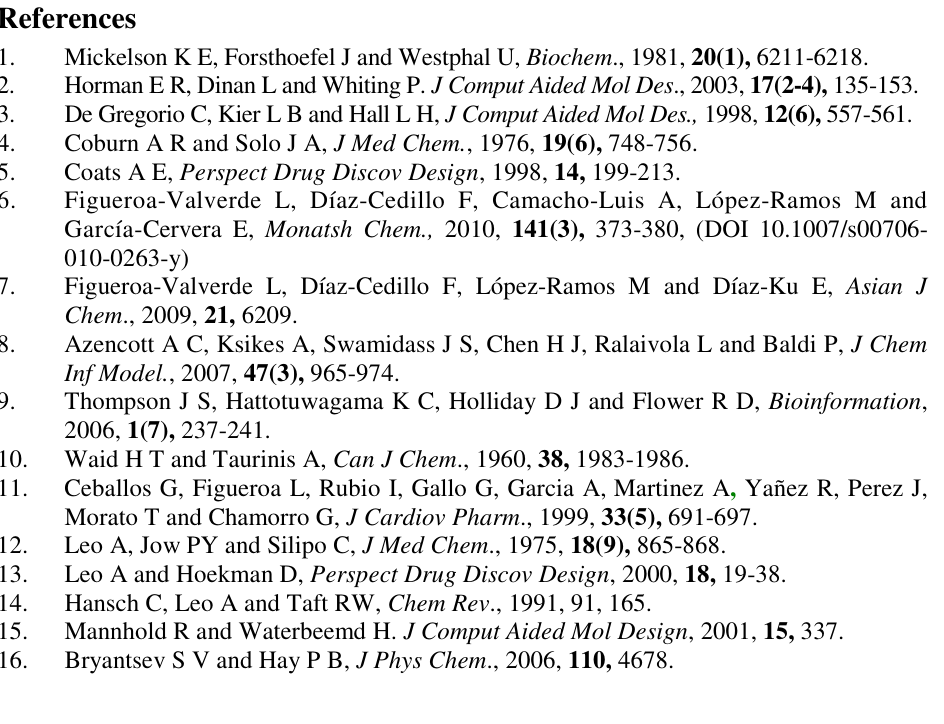
Table 3. Physicochemical parameters R